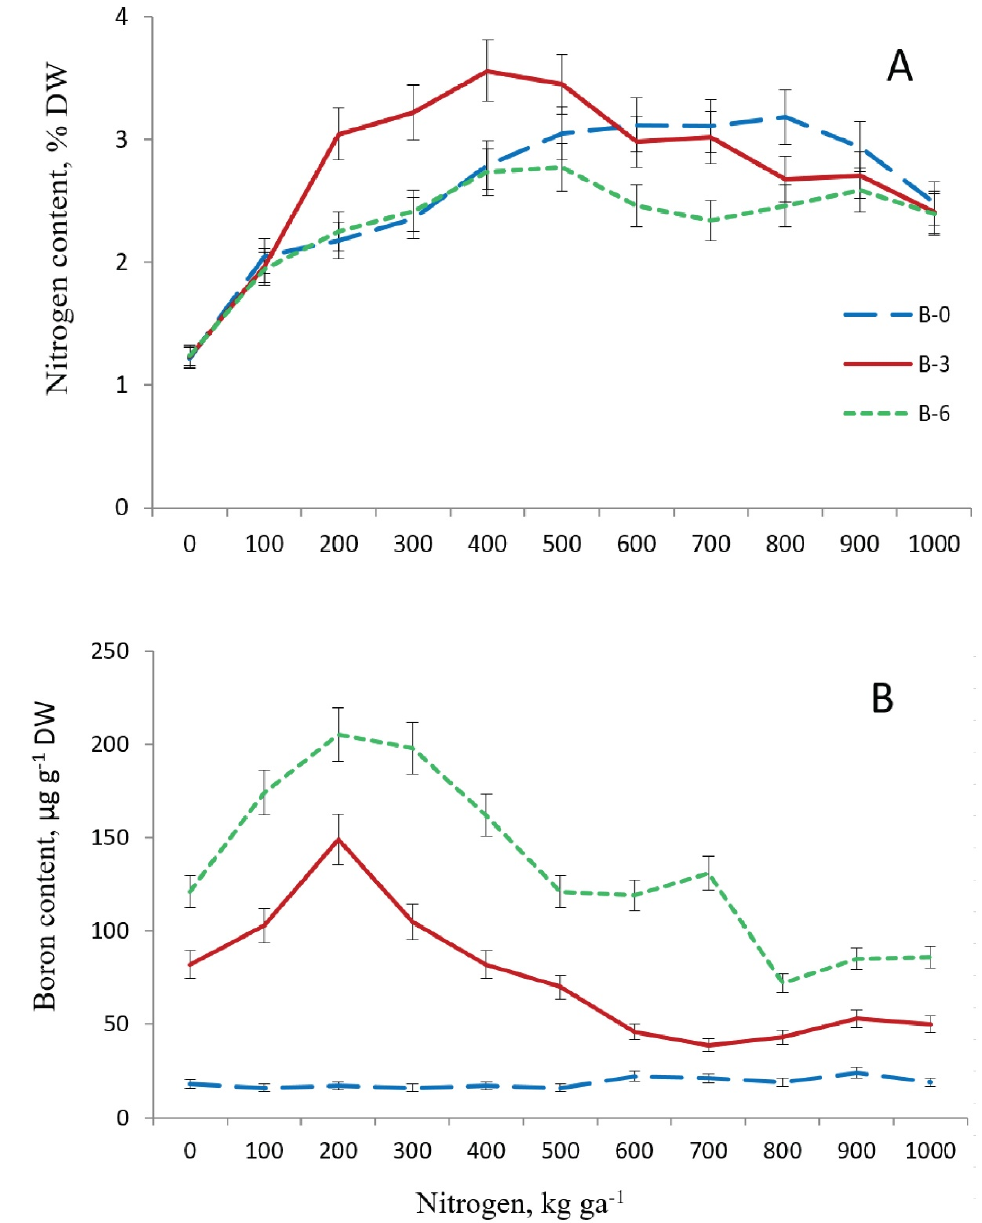
Figure 3. Nitrogen ( A ) and boron ( B ) content in one-year-old needles of 16-year old Pinus sylvestris L. depending on the doses of their application to soil. B0, B3, B6—boron doses of 0, 3.0, 6.0 kg ha − 1 , respectively. September 2014 (observations per plot n = 3).